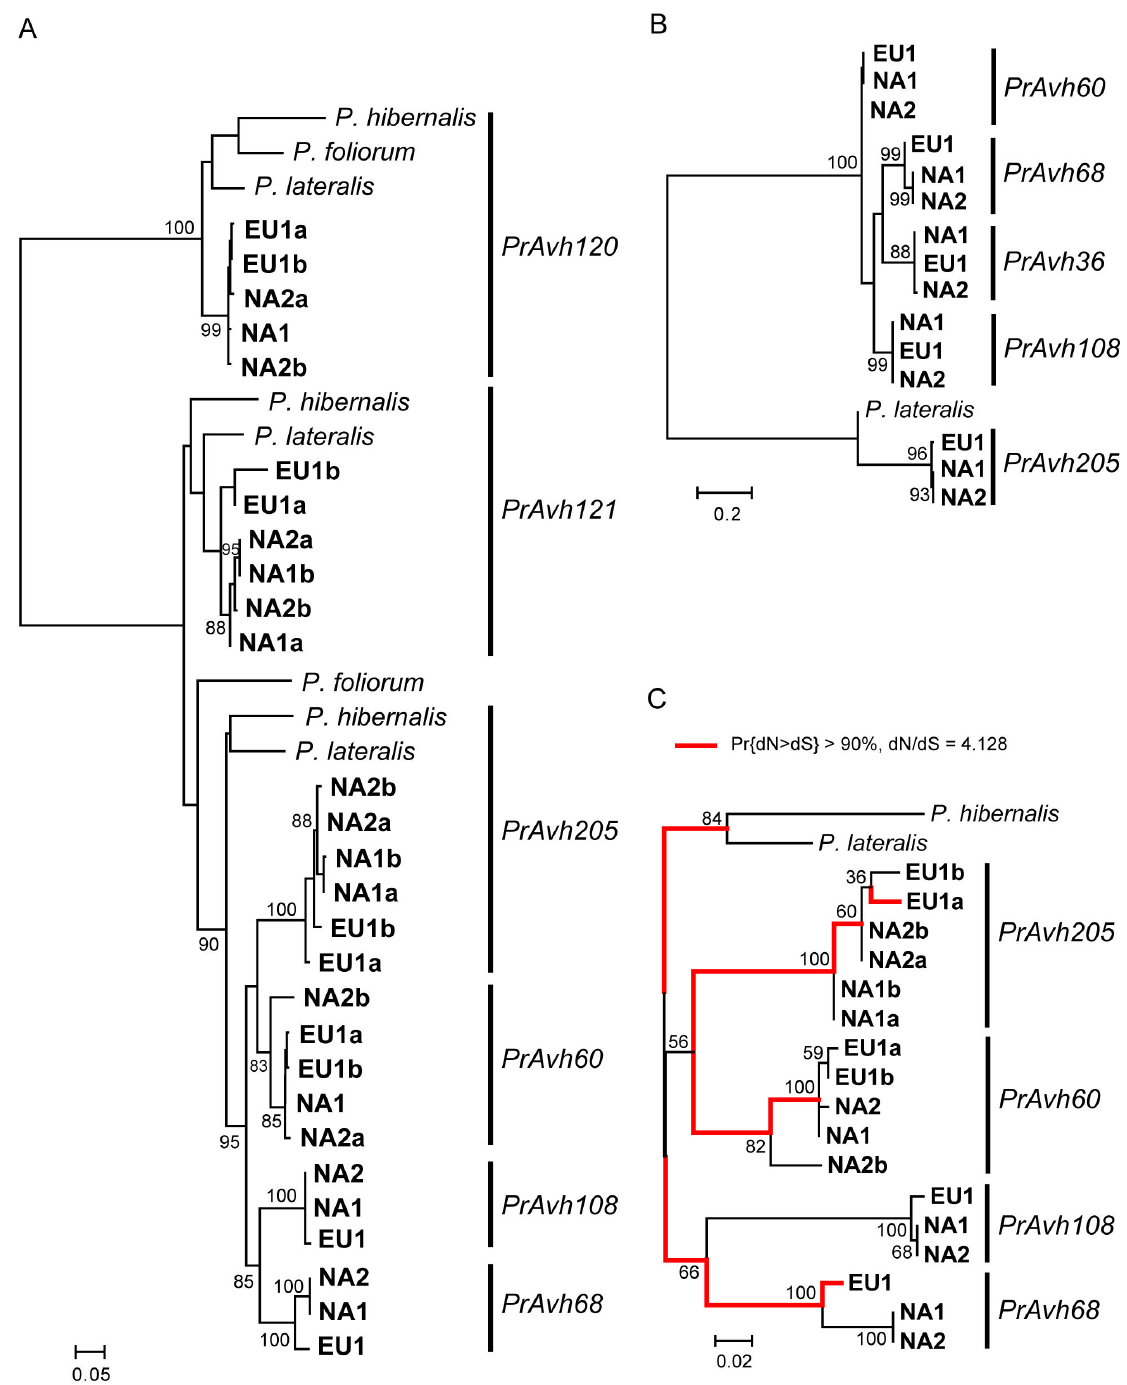
Figure 6. An RXLR effector gene family that has evolved primarily by point mutation. A. Maximum likelihood genealogy of the whole family and orthologous genes showing expansion of the family in P. ramorum . B. A maximum likelihood tree of the 5’ flanking region indicates orthologous and paralogous relationships among genes in the PrAvh205 clade. C. Branches exhibiting a high probability of positive selection based on analysis with GAbranch for sites 130-330 in the C-terminal region of the genes. The model-averaged probability of dN>dS was greater than 90% for all red highlighted branches. All but the terminal PrAvh68 branch for the EU1 lineage had probabilities greater than 95%. Branch support is indicated as a percentage of 500 bootstrap samples. The branch lengths are drawn to scale and measured in the number of substitutions per site. doi: